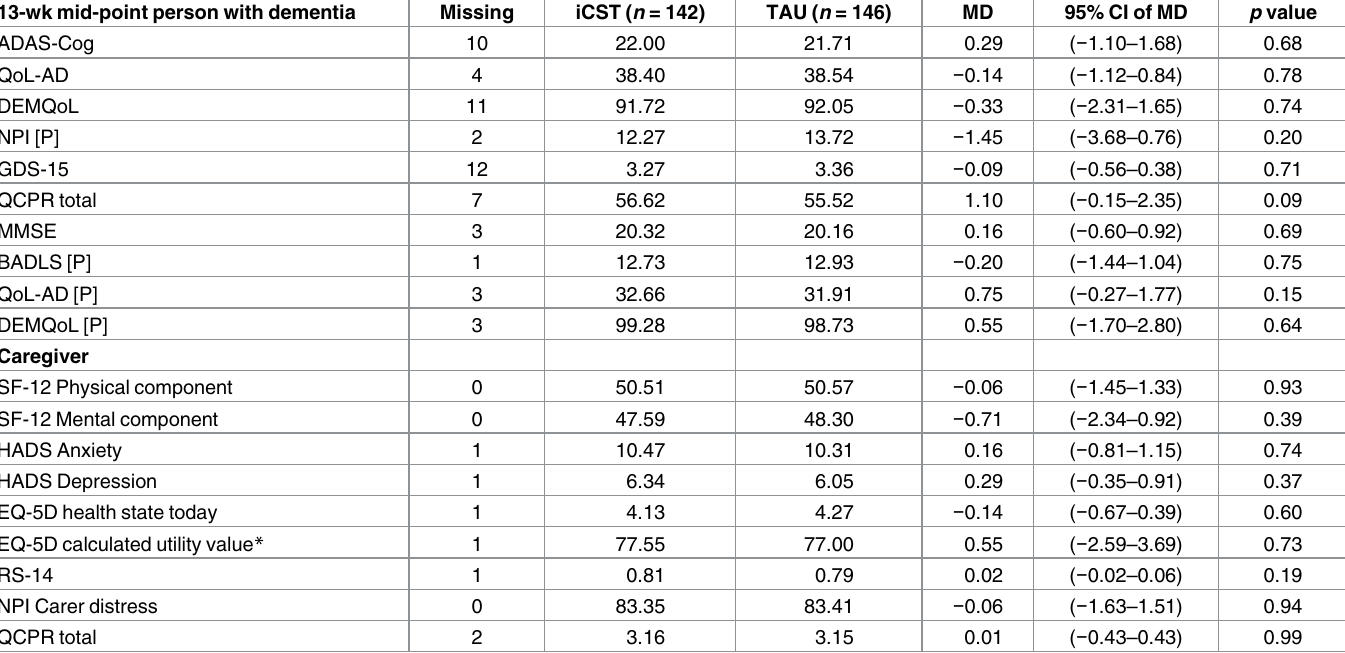
Table 3. The means (and 95% CIs) comparing the iCST and TAU for person with dementia outcome measuresat 13-wk mid-point after adjusting for marital status, centre, age, and anticholinesteraseinhibitors. (Completecase data are presented due to little difference betweenthis and imputed data